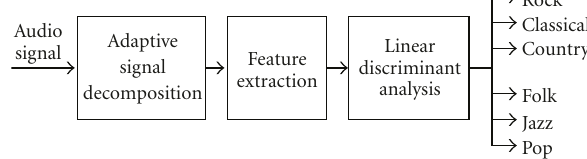
Figure 7: Block diagram of the proposed music classification